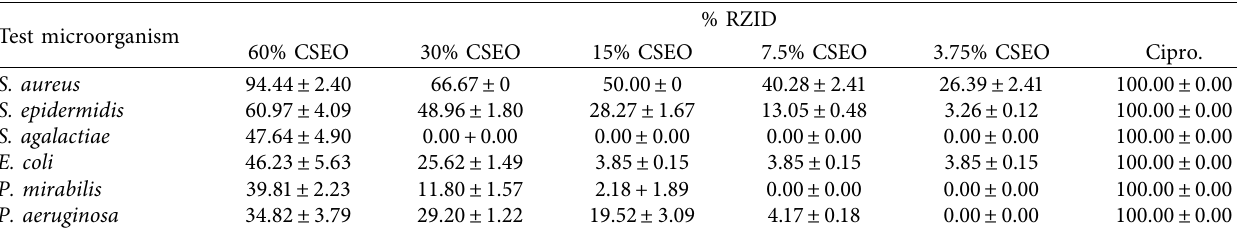
Table 3: Relative zone of inhibition diameter percentage (% RZID) of different concentrations of CSEO solution against test